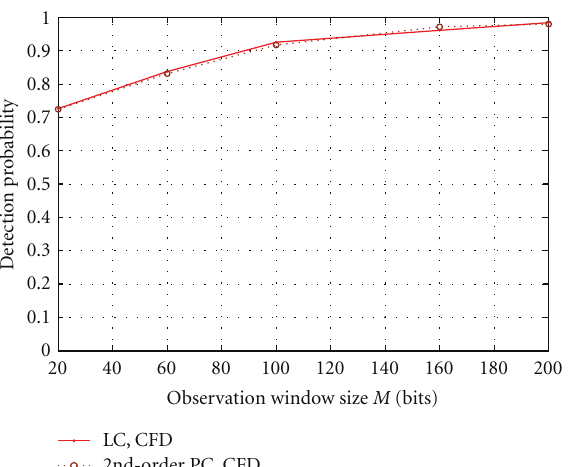
Figure 8: Impact of the window size on detection performance of cyclostationary-based schemes: SNR avg = − 14dB, N = 3 users, and P f = 10%.